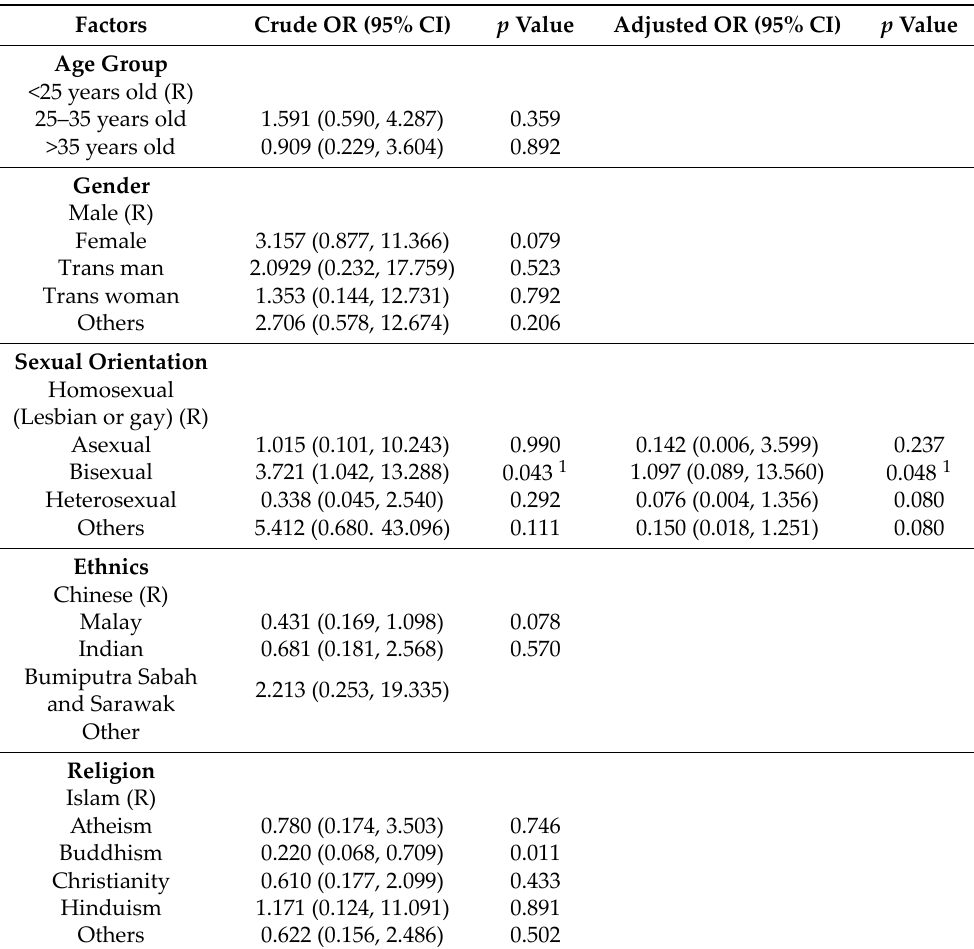
Table 4. Association of sociodemographic and primary coping styles with mental disorders among the LGBT+ community in